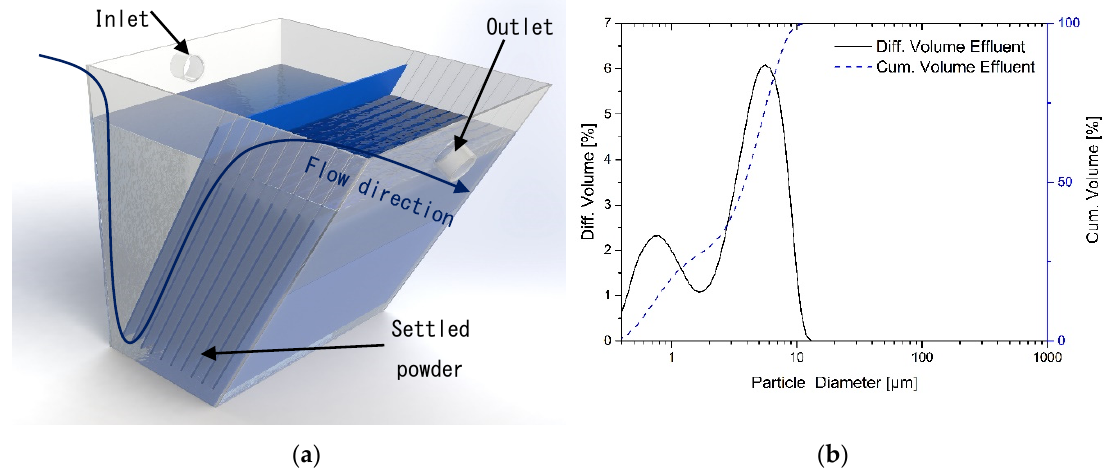
Figure 6. ( a ) Schematic representation of the designed settling tank; ( b ) Particle size distribution in the effluent from the outlet of the settling tank.